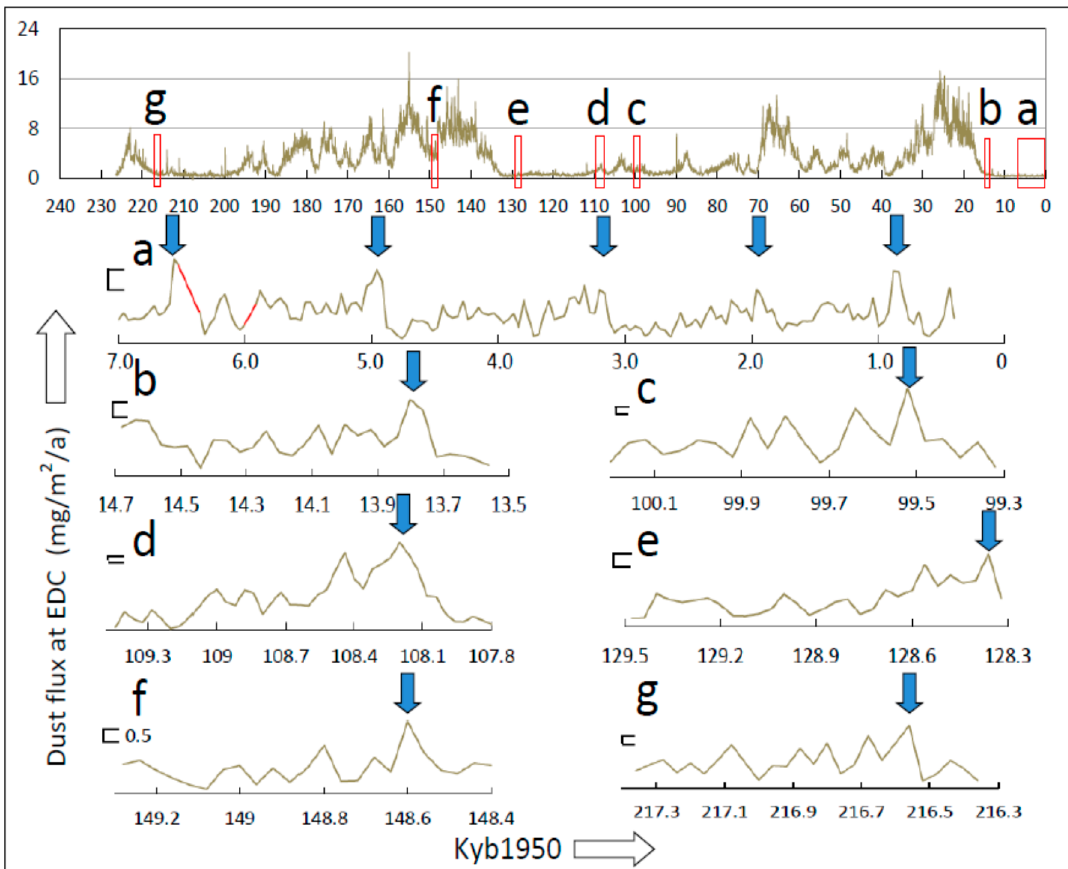
Figure 14. Time series of dust flux at EPICA Dome C (EDC) over the last 226 thousand years before 1950 (Kyb1950) showing the ubiquity and stereotypical form of the Antarctic Centennial Wind Oscillation (ACWO) on a millennial scale. Parts a-g represent time periods that correspond to the red rectangles labeled in the top panel. The calibration marks in ( b )-( g ) correspond to 0.1 mg/m 2 /a of dust flux except in part f, where the scale is 50 times greater. Vertical blue arrows point to Wind Termini (WTs). The red segments of the wind-proxy curve at 6000-5900 Kyb1950 (panel ( a ) only) depict a period of missing wind-proxy data that were filled by interpolation for visual but not analytic purposes.